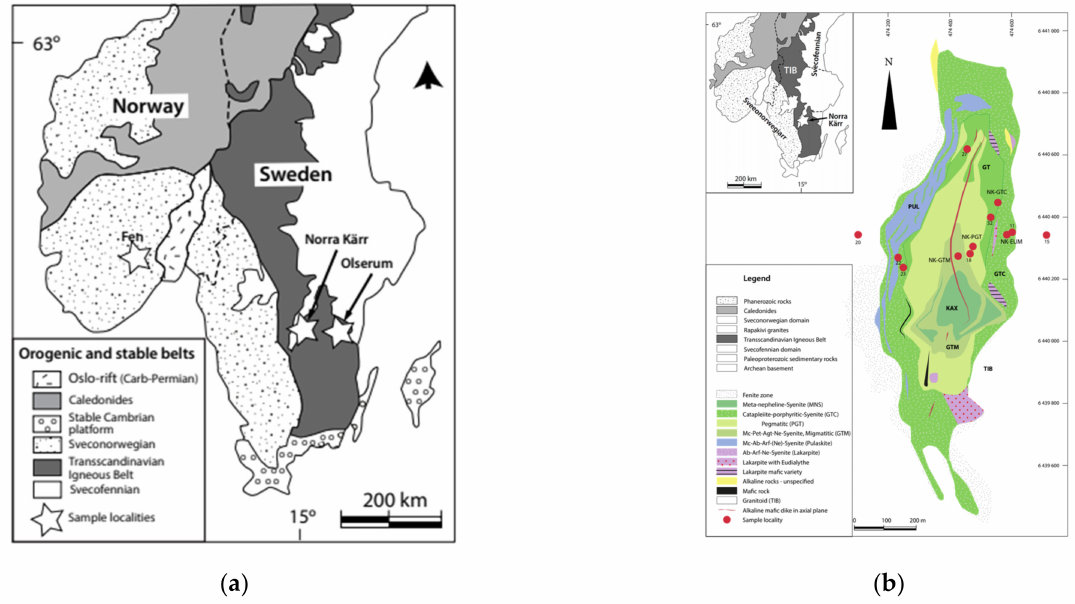
Figure 1. Maps of ( a ) all investigated deposits and ( b ) sample localities in Norra Kärr,